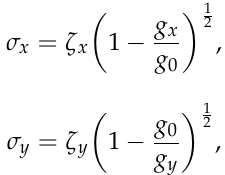
Figure 3. Quantitative example of the relationship among parameters. ( a ) Scatter plot of the hourly meridional winds (asterisks) at a height of 86 km measured by the two MRs and averaged over 14 months. The red line represents the regression of the 53.1 MHz MR winds on the 37.5 MHz MR winds, and the blue line indicates the opposite. The green line indicates the total least squares regression fit of all available data. The number of the selected meteors and the slopes of these three